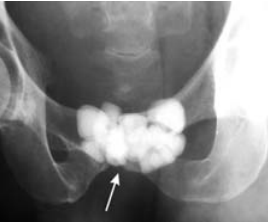
FIGURE 1. Plain film centred on the pelvis showing multiple stones in the prostatic area